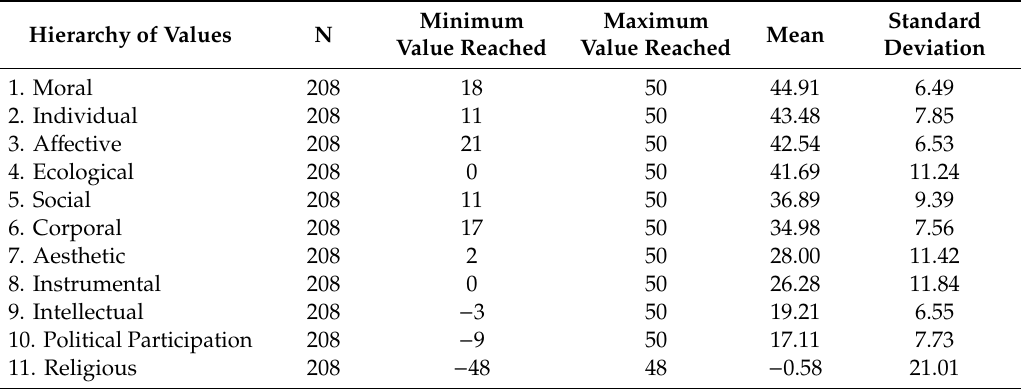
Table 3. Hierarchy of values of secular school